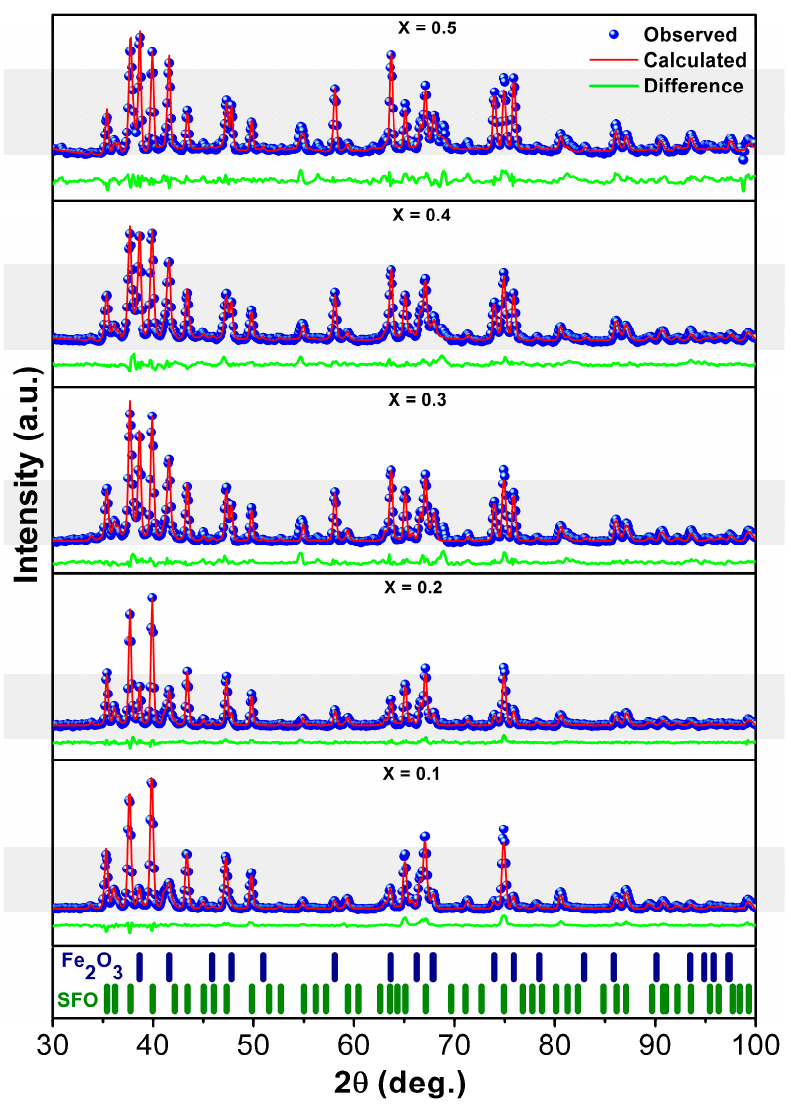
Figure 1. X-ray diffraction spectra of SrFe 12-x Nd x O 19 powders, where 0 ≤ x ≤ 0.5, and bar graphs of hexaferrite SFO and α -Fe 2 O 3 .